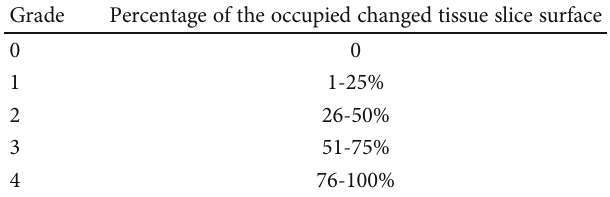
Table 1: The semiquantitative scale implemented for the assessment of the articular cartilage and synovial membrane degree of lesions in analyzed tissue slices per